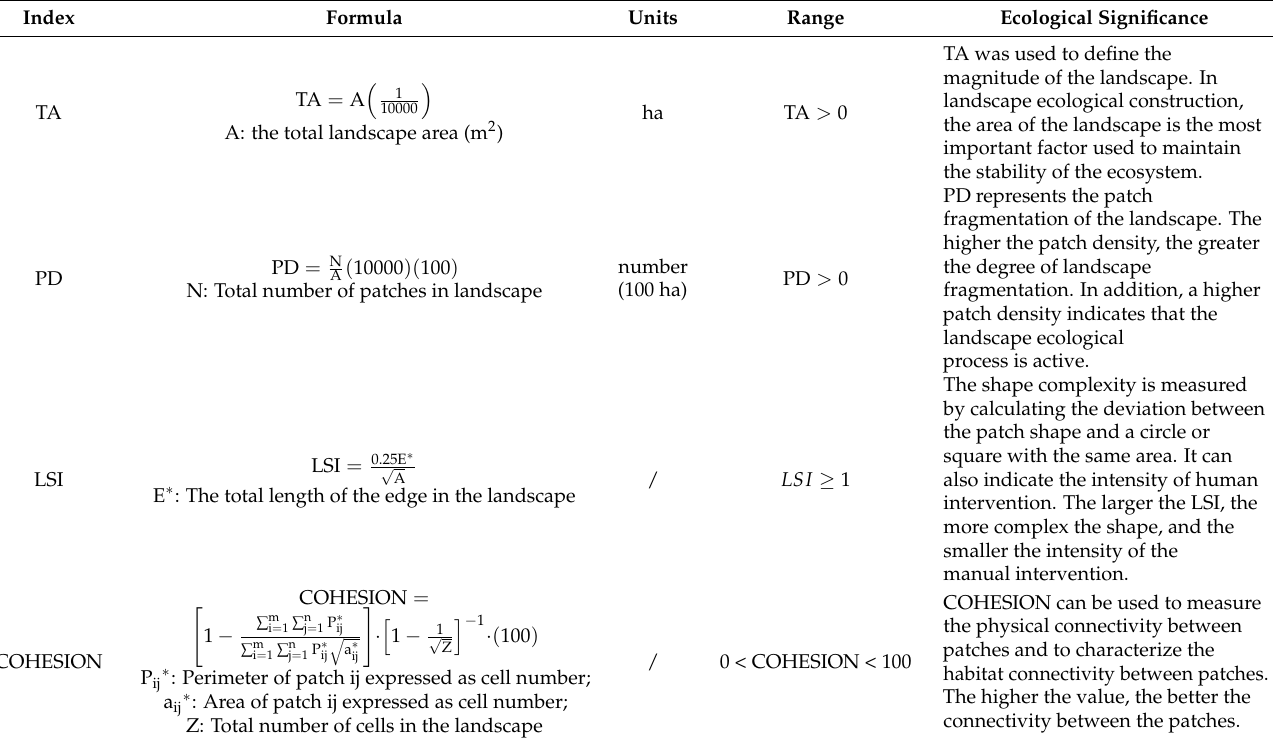
Table 3. The formulas for the representative indexes and their ecological